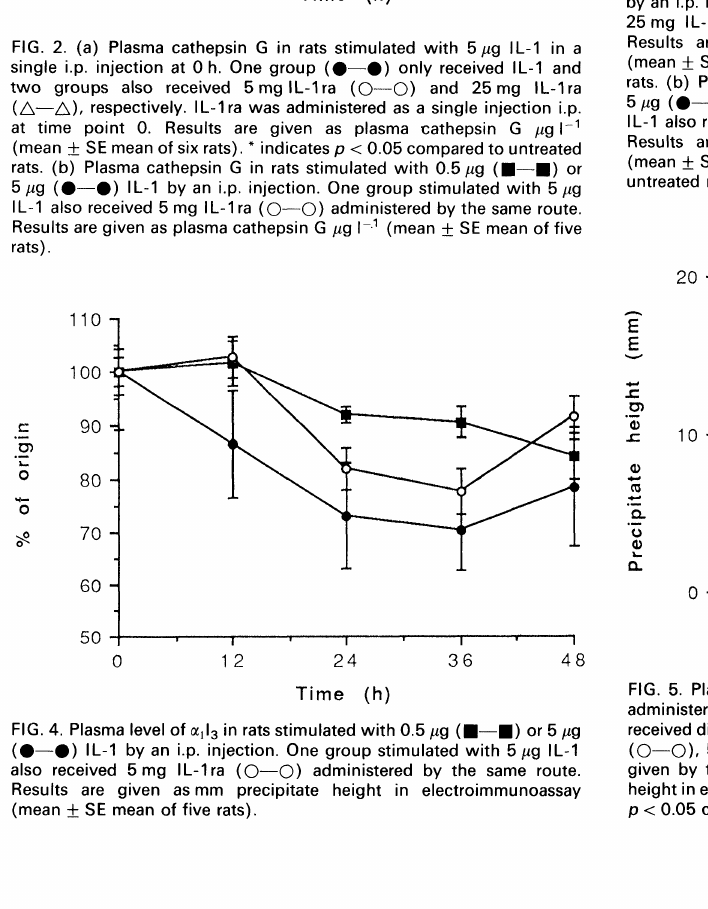
___ FIG. 3. (a) Plasma level of 2M in rats stimulated with 5 #g (--O) IL-1 by an i.p. injection. Two groups also received 5 mg IL-1 ra (O--O) and 25 mg IL-lra (/k--/k), respectively, administered by the same route. Results are given as mm precipitate height in electroimmunoassay SE mean of six rats). indicates p < 0.05 compared to untreated (mean rats. (b) Plasma level of o2[VI in rats stimulated with 0.5 #g (--) or 5 #g (--) IL-1 by an i.p. injection. One group stimulated with 5 #g IL-1 also received 5 mg IL-1 ra (O--O) administered by the same route. Results are given as mm precipitate height in electroimmunoassay (mean-I-SE mean of five rats). indicates p< 0.05 compared to untreated rats. ___ FIG. 5. Plasma level of amyloid P in mice stimulated with 0.5 #g IL-1 administered by an i.p. injection. After the IL-1 injection the four groups received different amounts of IL-1 ra; 0 mg IL-1 ra (--), 0.5 mg IL-1 ra (O--(C)), 5mg IL-lra (I--I--I-q) and 10mg IL-lra (/X--/X). IL-lra was given by the same route as IL-1. Results are given as mm precipitate SE mean of five mice). indicates height in electroimmunoassay (mean p < 0.05 compared to untreated